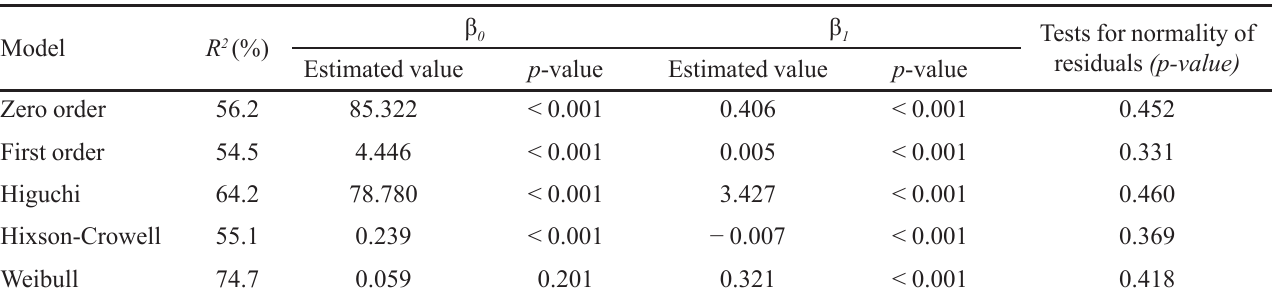
TABLE IV - Results of the regression fit models for MMF-IR dissolution profile in selected medium 0.1 M HCl, using UV method, λ 250 nm